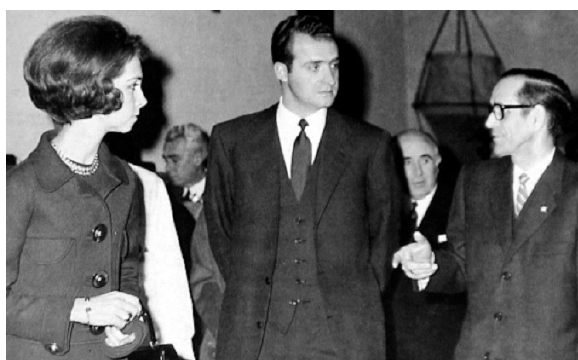
Visit of Prince Juan Carlos (middle) and Princess Sofía (left) of Spain to the IIP headquarters laboratory in Barcelona, November 8-9, 1972. Buenaventura Andreu